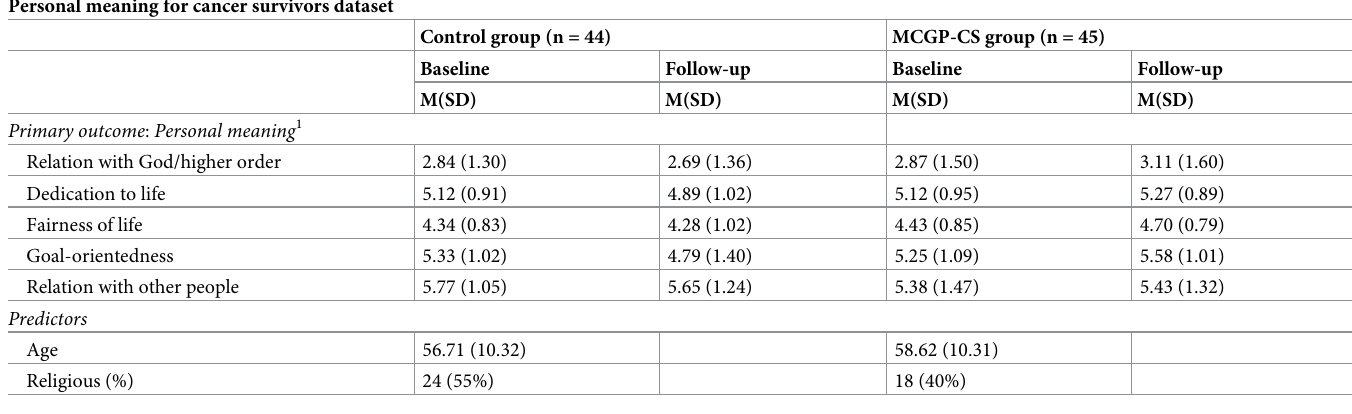
Table 2. Means and standard deviations of the primary outcome and predictors used for response shift analyses of the personal meaning for cancer survivors dataset. Personal meaning for cancer survivors